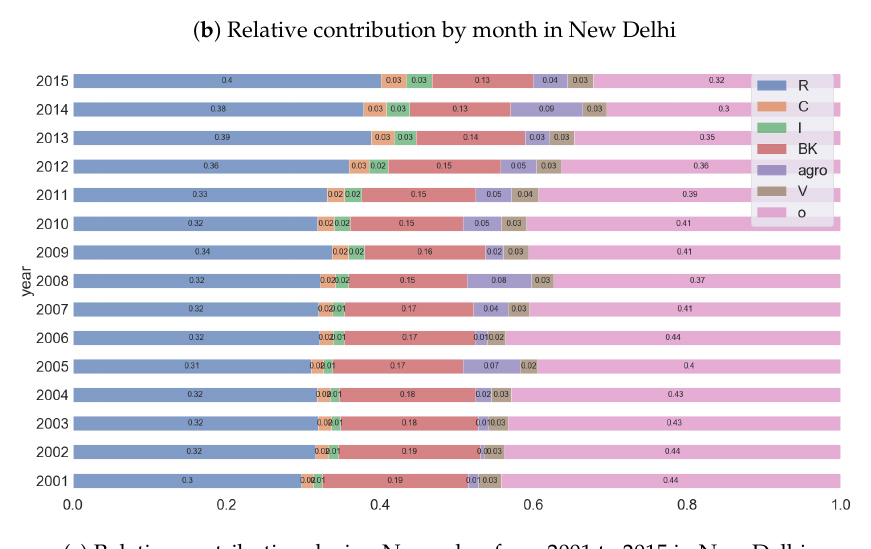
Figure 9. Comparison of relative contribution to R est over the central grid cell from concentration due to primary emission for all the cities for November, 2015 and month November ( a ). For New Delhi, changes in monthly contribution and changes across the years for the month of November is shown in ( b ) and ( c ) respectively. The contribution is represented by residential (R), commercial (C), industrial (I), agriculture related fires (agro), brick kilns (BK), vehicles (V). EA O indicates formation of secondary particles, meteorological transport and unaccounted sources and is labeled as ‘o’